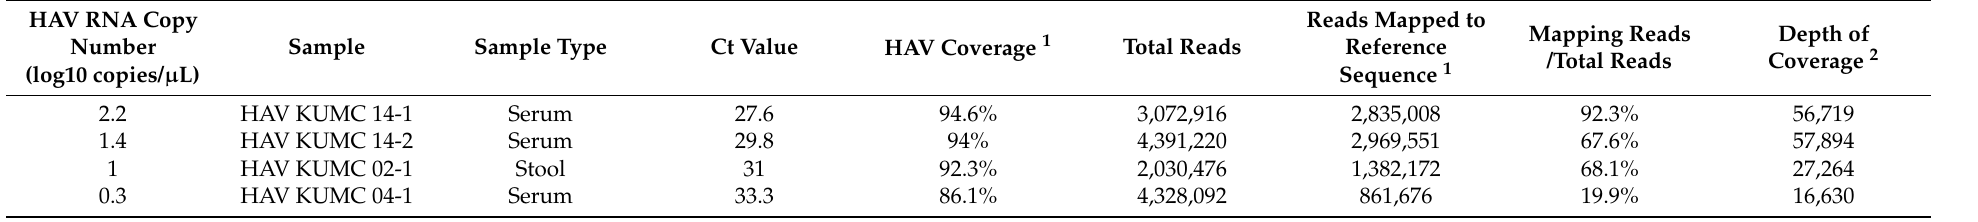
Table 2. Summary of total reads and read mapping to hepatitis A virus (HAV) genomes by multiplex polymerase chain reaction-based next-generation